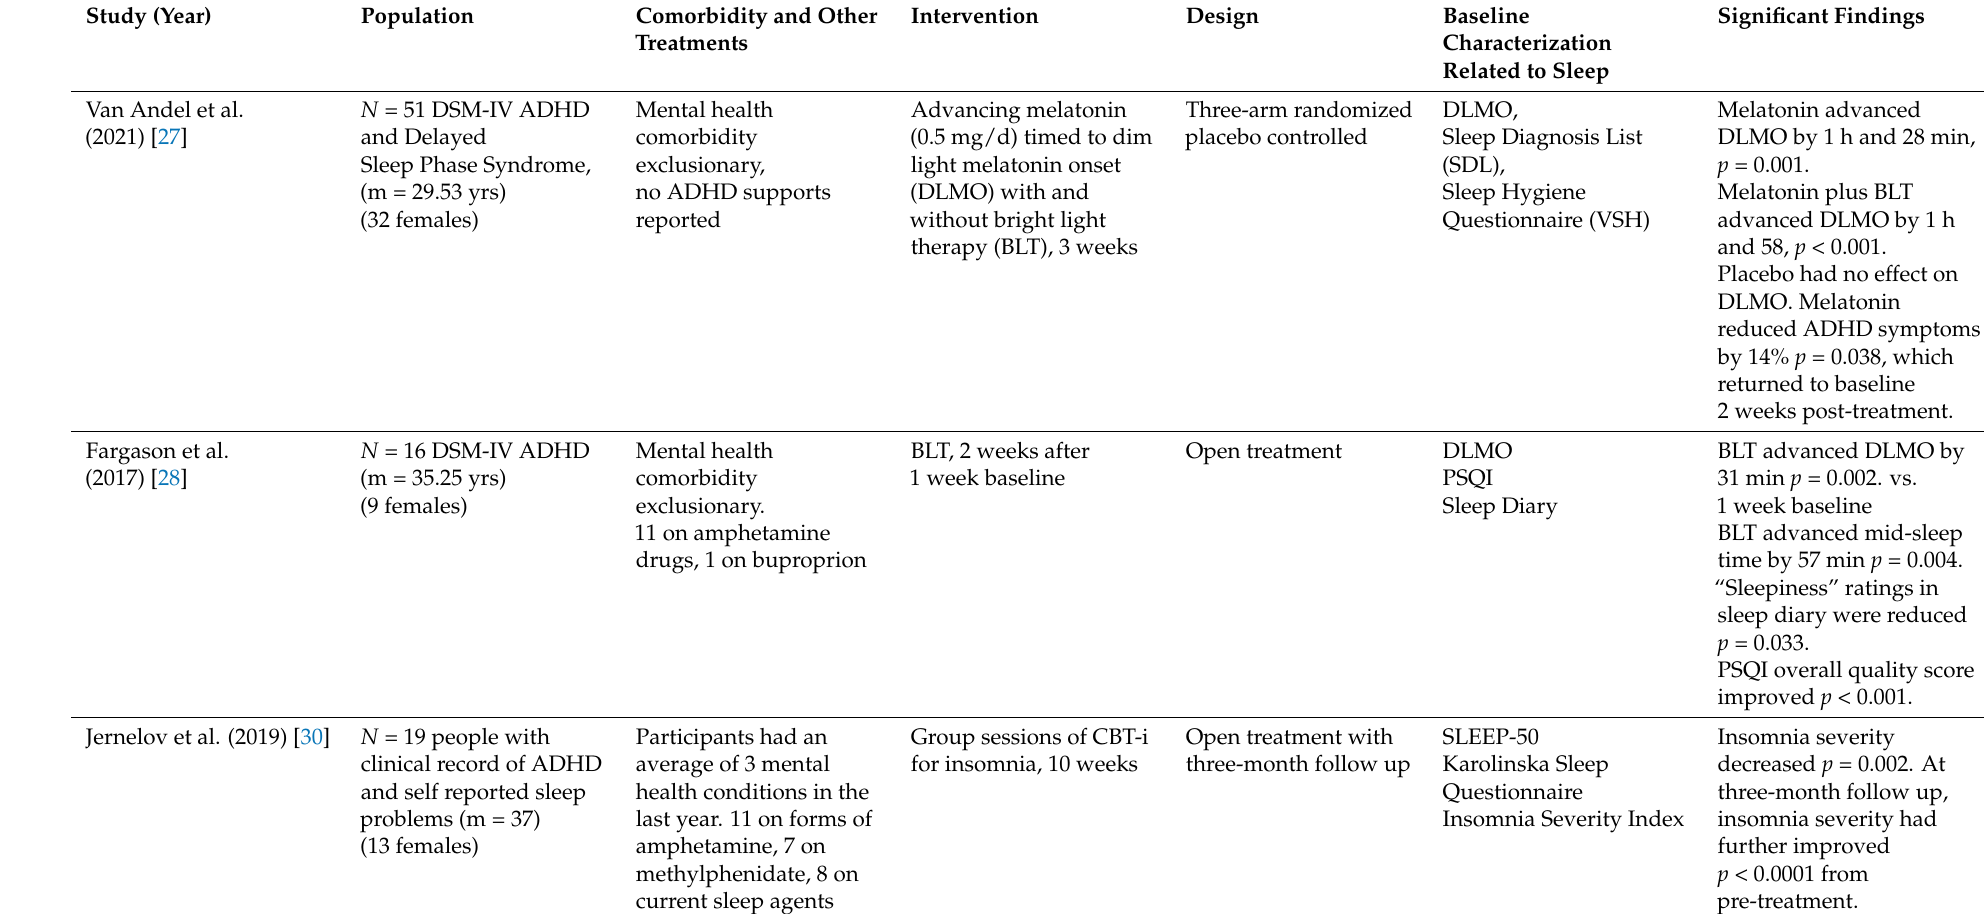
Table 1. Prospective studies of sleep intervention in adults with